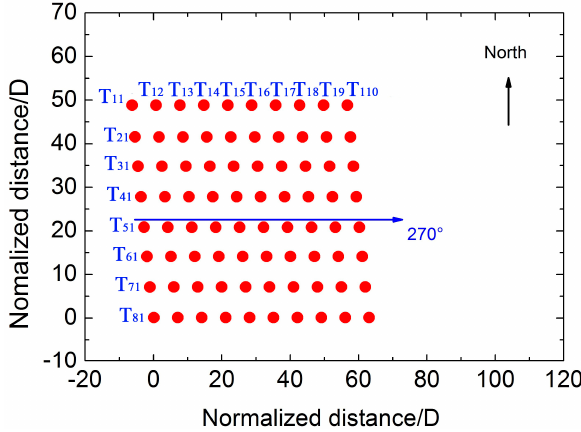
Figure 7. Layout of the Horns Rev wind farm.